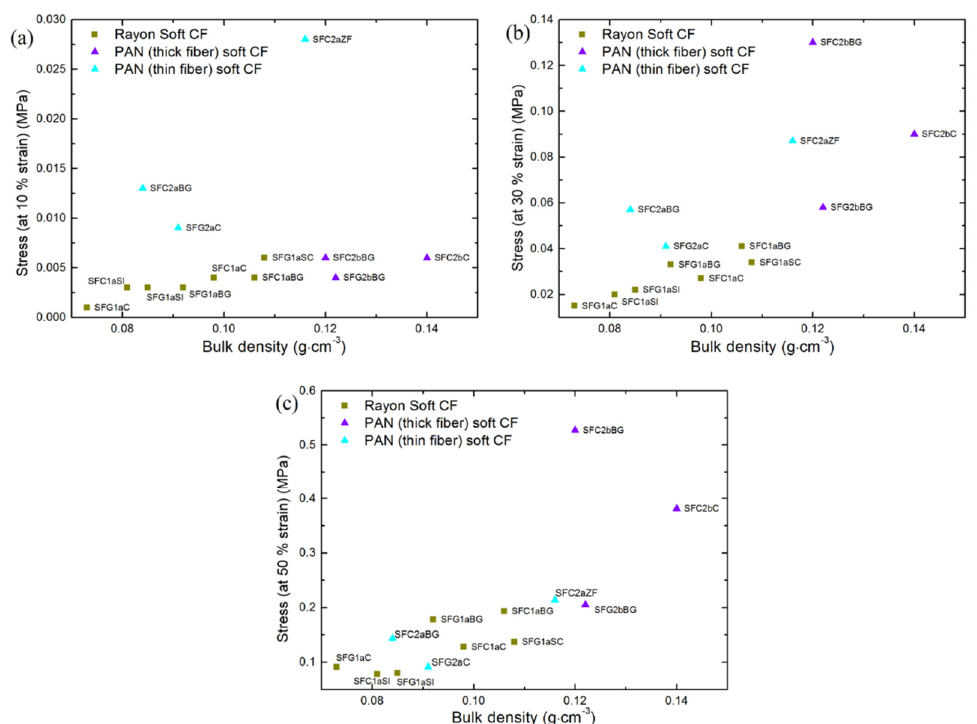
Figure 3. Effect of bulk density on the stress applied to CFs for deforming them at: ( a ) 10% strain; ( b ) 30% strain and ( c ) 50% strain.